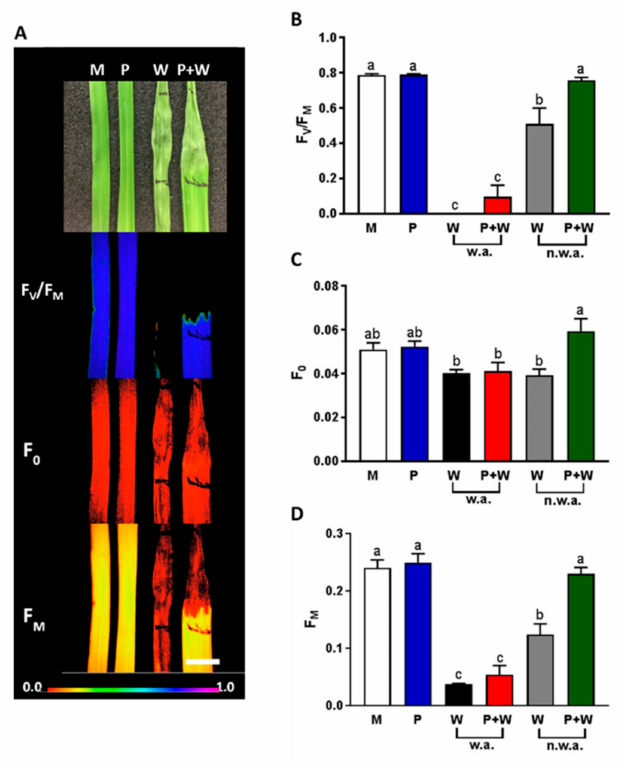
Figure 7. Measurement of chlorophyll fluorescence. Representative images of rice leaves mock (M); primed with MeJA (P); wounded (W); primed and wounded (P + W) in brightfield, maximum quantum e ffi ciency of Photosystem II (F V / F M ), minimal (F 0 ) and maximal fluorescence (F M ) (panel A ). The color bar below shows the range of fluorescence values. Scale bar: 5 mm. Means ( n = 5) ± SE of F V / F M ( B ), F0 ( C ) and FM ( D ) values are shown. In all bar panels, white bars represent M, blue bars P, black bars W (w.a. = wounded area)), red bars P + W (w.a.), grey bars W (n.w.a = near wounded area), green bars P + W (n.w.a.). A one-way ANOVA followed by Tukey’s test was performed to define statistical significance ( p < 0.05) of di ff erences among means. Data not sharing the same letters are statistically significantly di ff